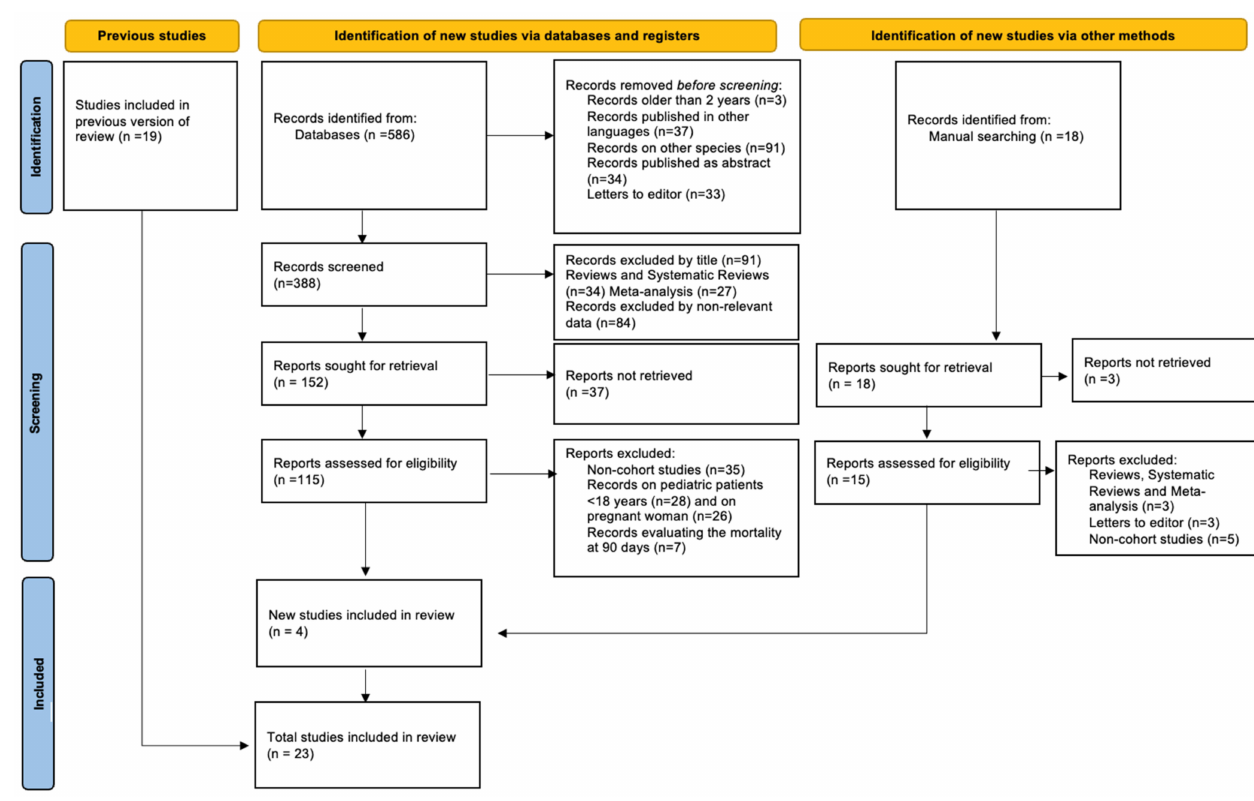
Figure 1. Flow diagram of literature search, screening, inclusion and exclusion of studies. Table 1. Studies supporting the theory of